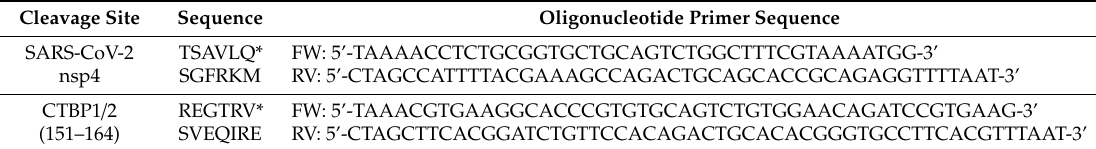
Table 3. Oligonucleotide primers used for cloning. pDest-His 6 -MBP-mEYFP expression vectors were prepared by ligating the following complementary oligonucleotide primer pairs—coding for the cleavage site sequences-into the plasmid. CTBP1 (151–164) sequence is fully identical in CTBP1 and CTBP2 proteins. FW: forward; RV: